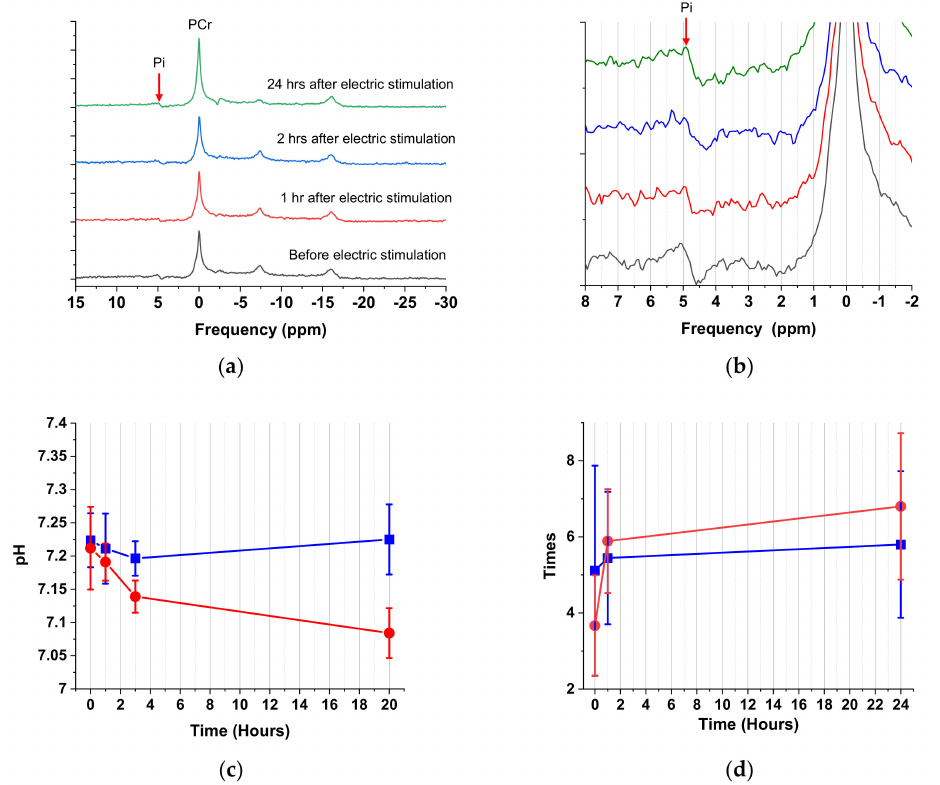
Figure 6. ( a ) 31 P MRS of the electrical stimulation group. ( b ) A close-up ( − 2.0–8.0 ppm) of the 31 P MRS data showing the Pi chemical shift variation over time. The frequency at which Pi moves up-field with time. The chemical shift between PCr and Pi was measured by 31 P MRS and then using Equation (5). ( c ) The time-dependent pH of the electrical stimulation group ( • ) and control group ( (cid:4) ) using 31 P MRS analysis. ( d ) The von Frey test results for the paws with ( • ) and without ( (cid:4) ) electrical stimulation.